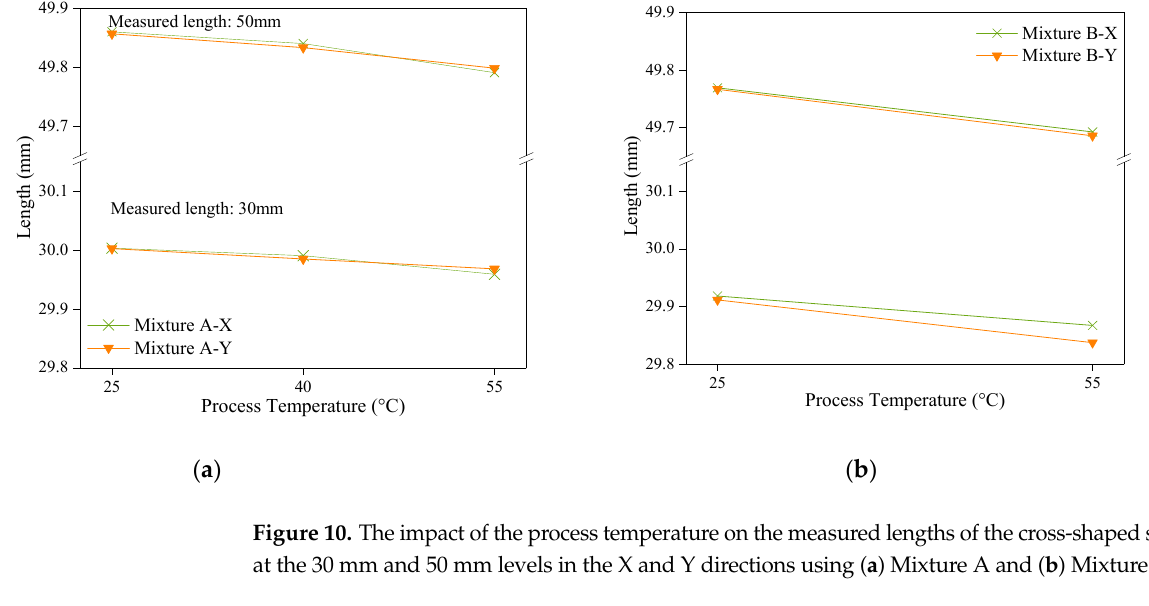
Figure 10. The impact of the process temperature on the measured lengths of the cross-shaped specimen at the 30 mm and 50 mm levels in the X and Y directions using ( a ) Mixture A and ( b ) Mixture B.